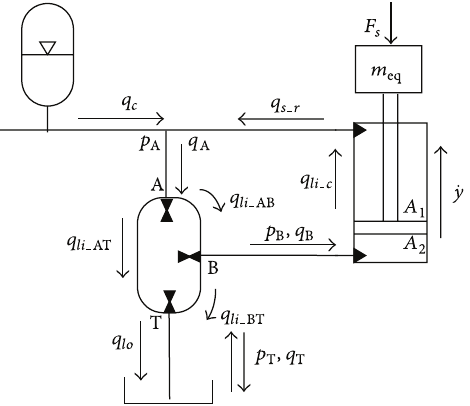
Figure 8: Schematic of SHT control cylinder.